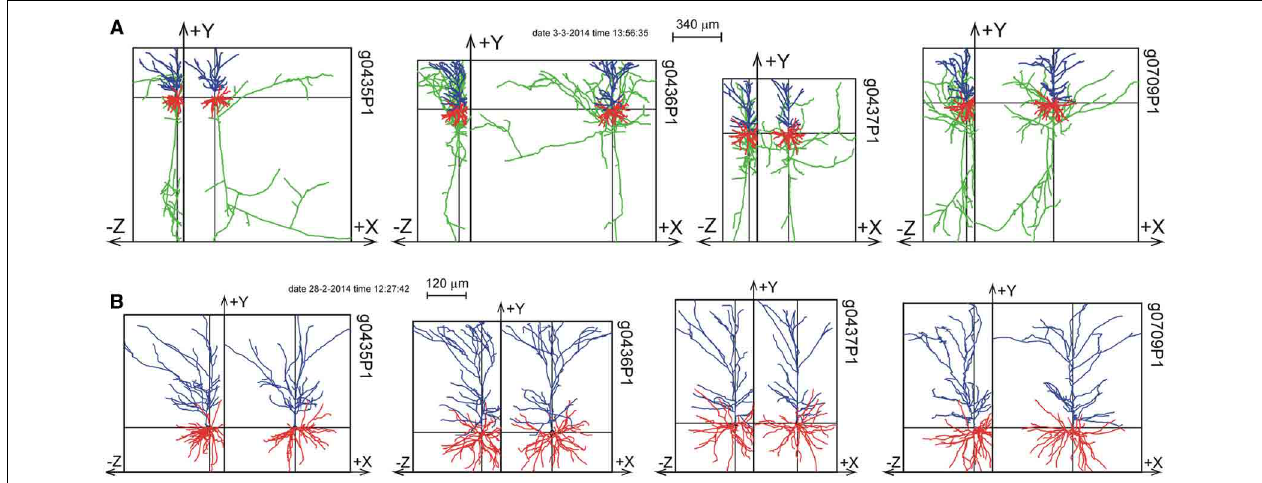
FIGURE 6 | Selection of 4 out of 11 reconstructions of rat cortical L2/3 pyramidal neurons (Shepherd and Svoboda, 2005) plotted as projections on the XY and YZ planes. The neurons are aligned with their apical main stem into the Y-axis. (A) Plot of axons and